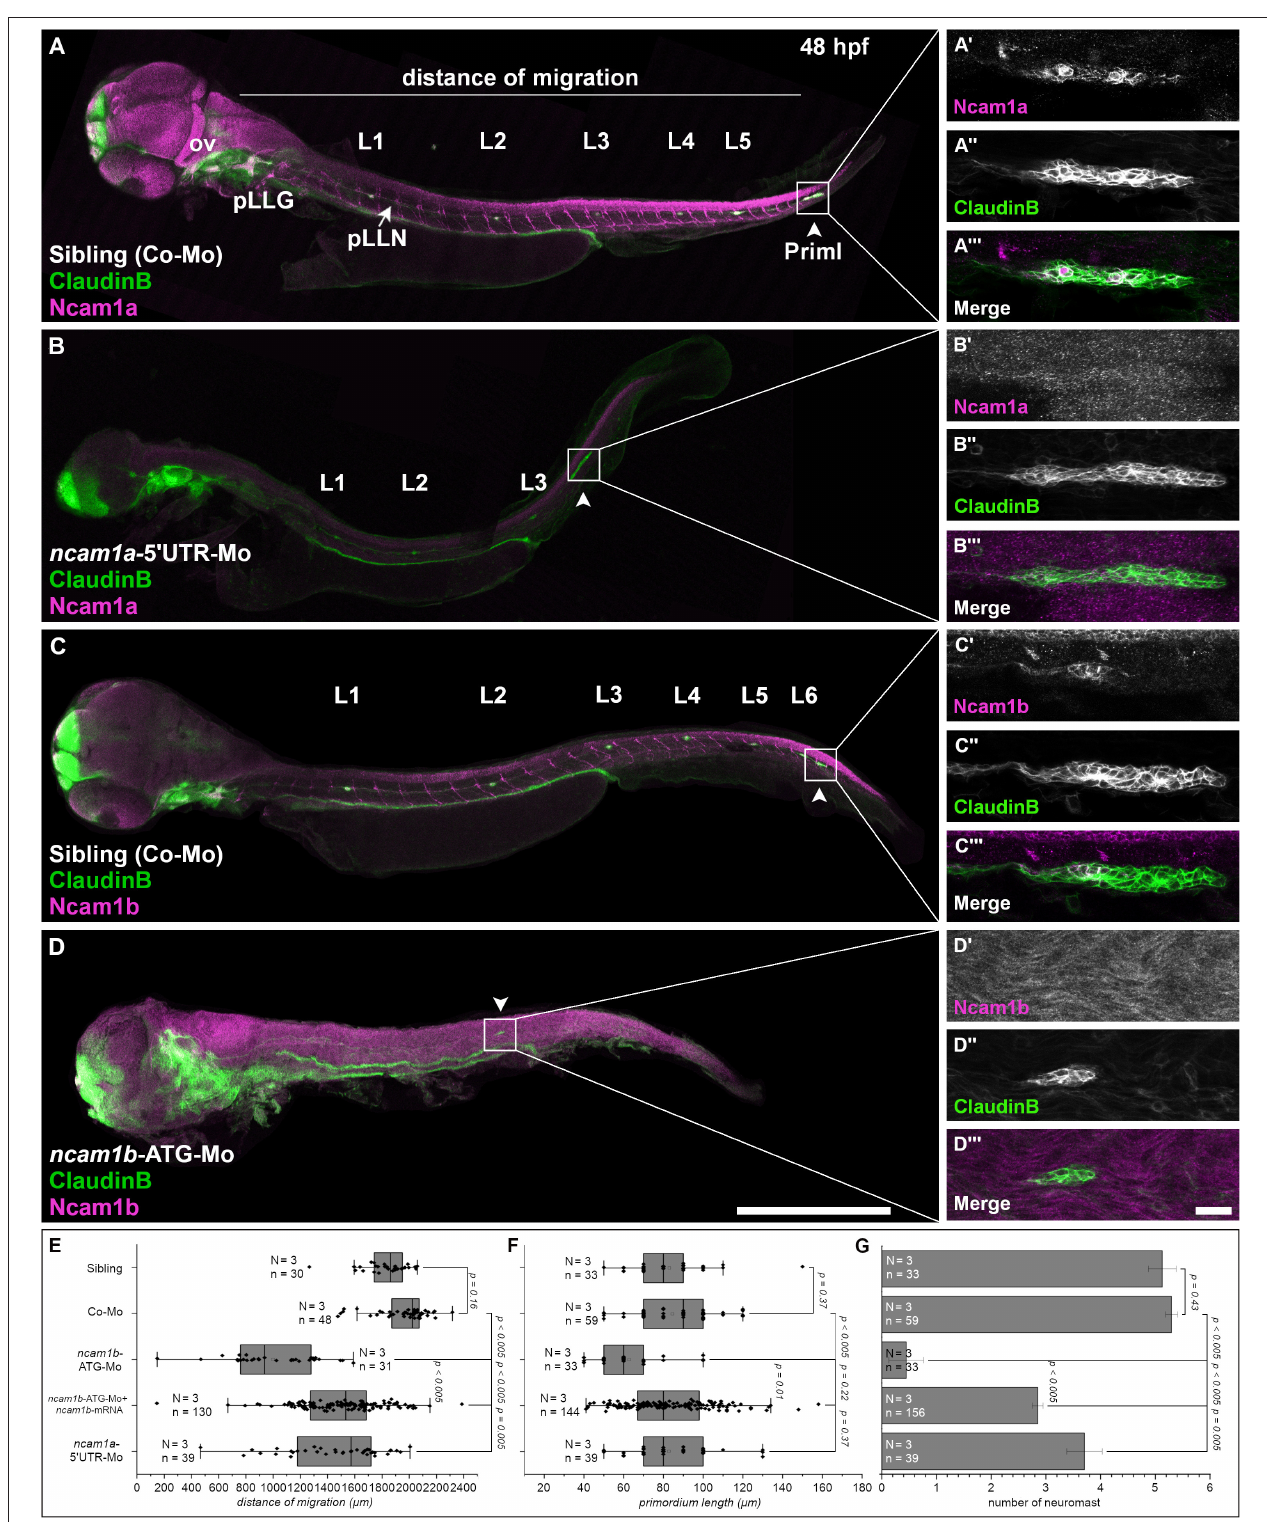
FIGURE 1 | Expression pattern and function of Ncam1 during development of the zebrafish lateral line system. (A–D) Lateral views of Tg(ClaudinB::lynGFP) (green) embryos (48 hpf) immunostained for Ncam1a or Ncam1b (magenta). (A,C) Control-Morpholino (Co-Mo) injected sibling; all structures (excluding interneuromast cells)